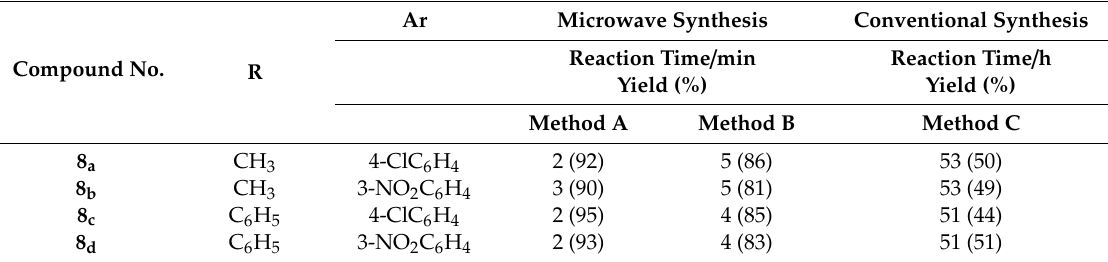
Table 1. Yield and reaction time comparison between microwave and conventional methods in the synthesis of 5-arylazo-3-cyano-2-(2 ″ ,3 ″ ,4 ″ ,6 ″ -tetra- O -acetyl- β - D -galactopyranosyloxo)-pyridines ( 8 a– d ). Compound